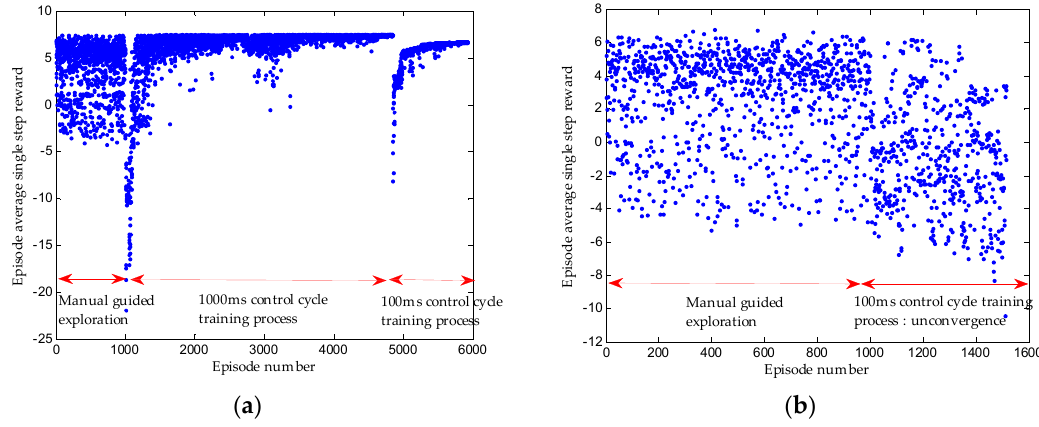
Figure 13. ( a ) Training process first by 1000 ms control cycle and followed by 100 ms control cycle. ( b ) Training process only by 100 ms control cycle.